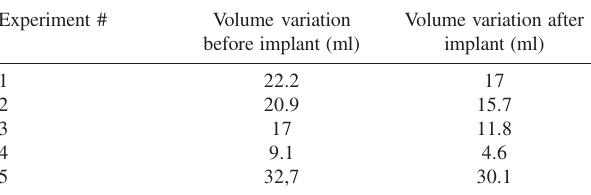
Table 2 - Pulsatility before and after endograft implantation in the 5 aneurysms, represented by volume variation. Variation was not significant at